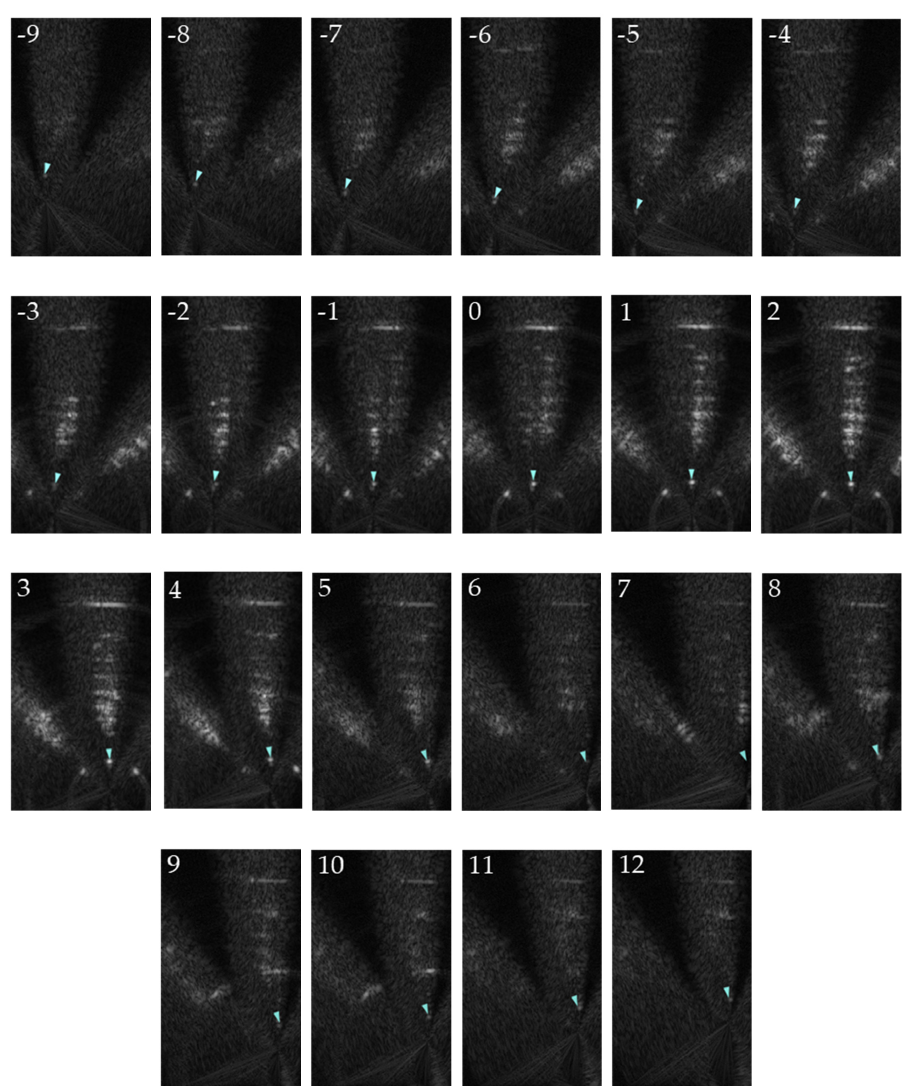
Figure 3. Bistatic GB-SAR images with one stationary and one moving antennae. Numbers correspond to the locations of the stationary antenna in Figure 1a. The position and viewing direction of the stationary antenna is depicted in each image.